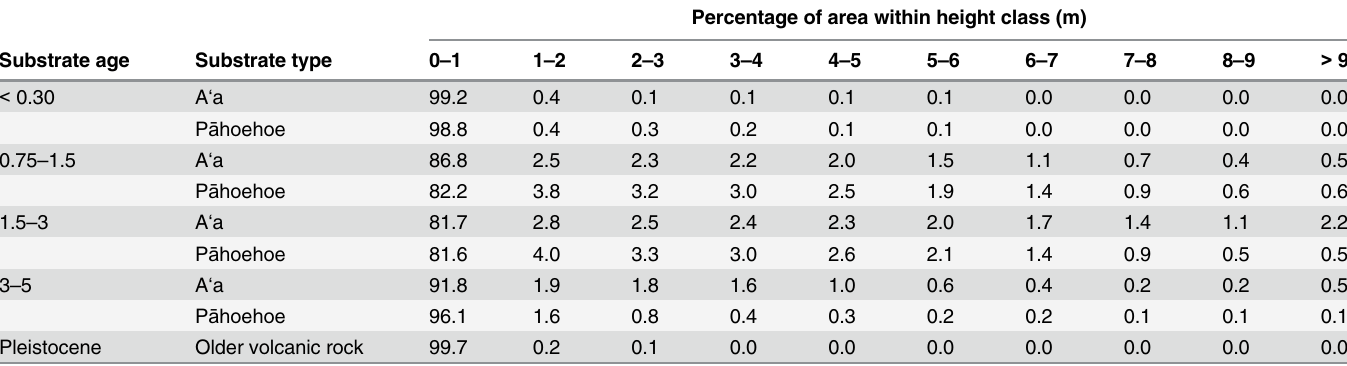
Table 2. Distributions of vegetation height on substrates of the P ō hakuloa substrate age gradient.